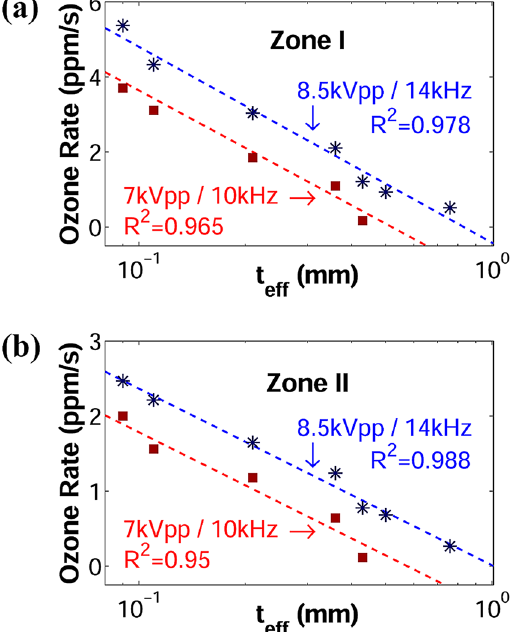
Figure 6. Ozone rate vs. t eff at voltage/frequency pairs 7 kVpp/10 kHz and 8.5 kVpp/14 kHz. ( a ) Zone I . ( b ) Zone II .